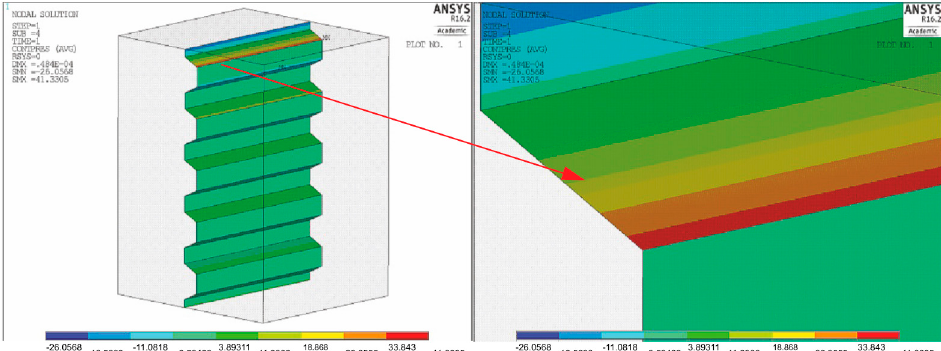
Figure 8. Pressure distribution of the coping surfaces and magnification of the surface of the first groove. σ cont max = 41 MPa.